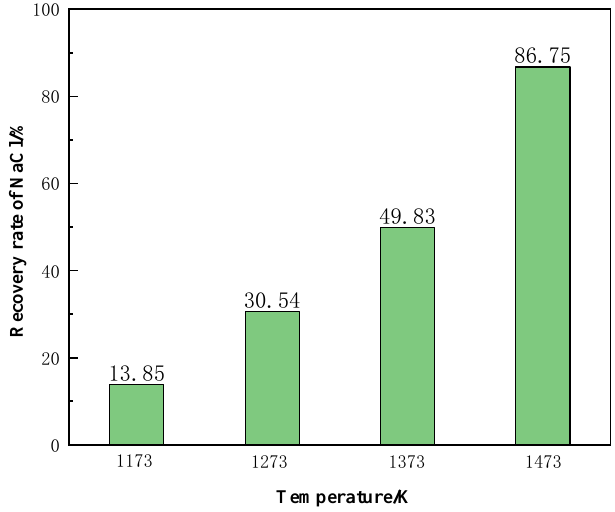
Figure 19. Effect of different temperatures on the recovery rate of NaCl.